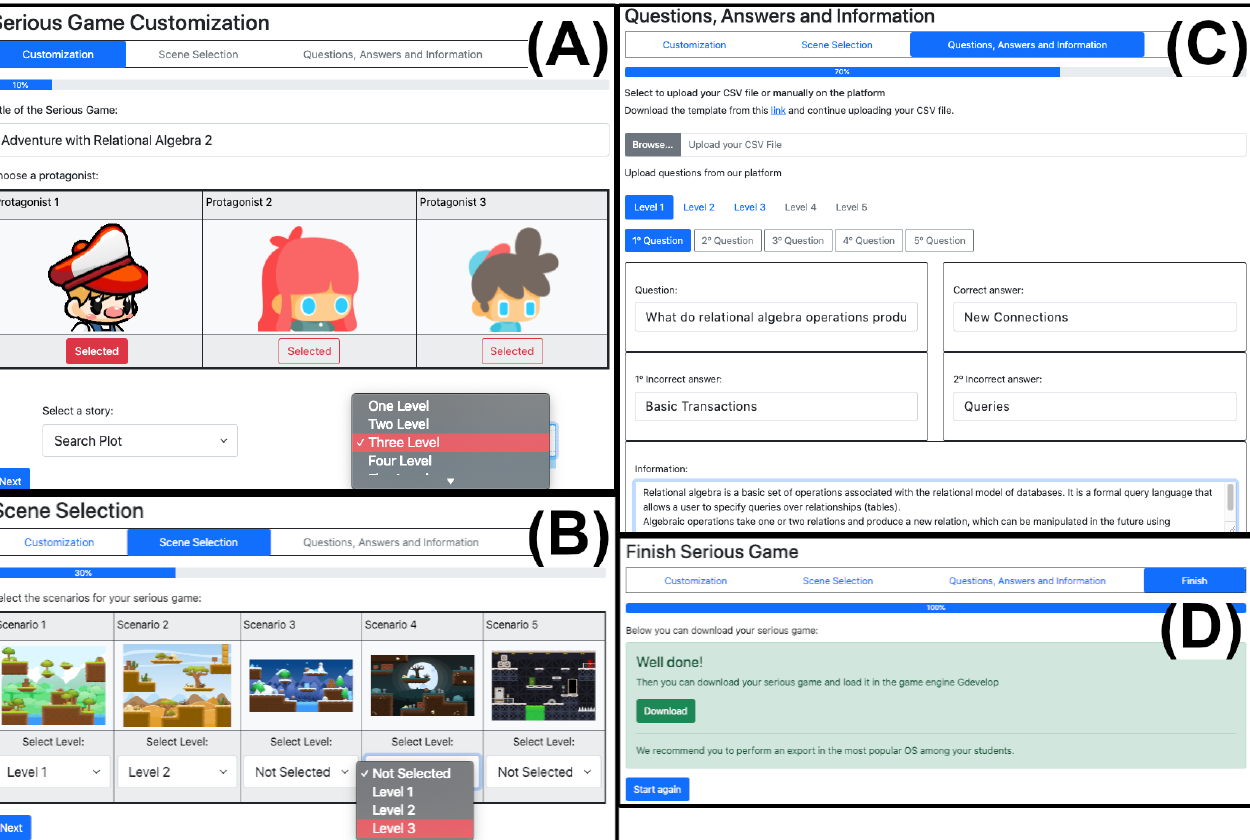
Figure 4. In ( A ), SG customization takes place, in ( B ) levels are selected, in ( C ) questions and answers are loaded, and in ( D ) there is a graphical interface for downloading the